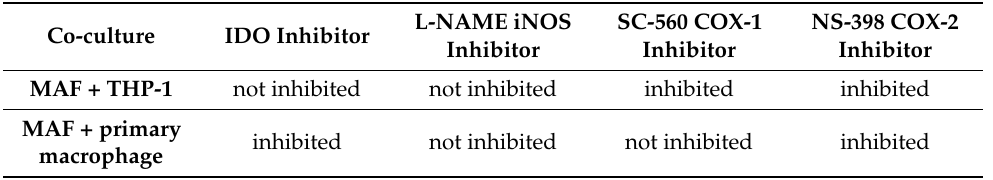
Figure 11. Inhibitors of IL-10 production in MAF/THP-1 macrophages co-culture. Ratio of IL-10 concentration of MAF/THP-1 co-cultures to THP-1 monocultures treated with different concentrations of 1-methyl-d-tryptophan (IDO inhibitor) ( a ), NG-nitro-L-arginine methyl ester (L-NAME) iNOS inhibitor ( b ), SC-560 COX1 inhibitor ( c ), and NS-398 COX2 inhibitor ( d ), n = 4. Error bars represent means ± s.e.m. ** p < 0.005 and *** p < 0.0005. Table 2. Summary of IL-10 inhibition in either MAF + THP-1 macrophage co-culture or MAF + primary macrophage co-culture. “Inhibited” indicates that IL-10 production of co-culture was inhibited by the effect of inhibitor, while “not inhibited” refers to lack of inhibition.